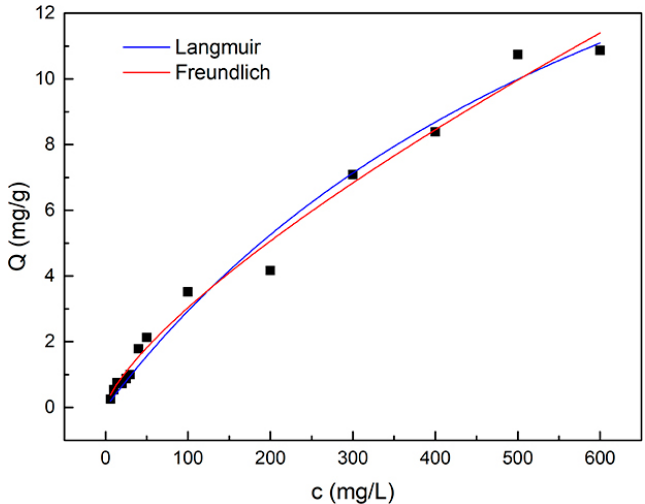
Figure 7. Adsorption isotherms of catechol on the g-C 3 N 4 /Fe 3 O 4 composite. Lines are the model correlations.